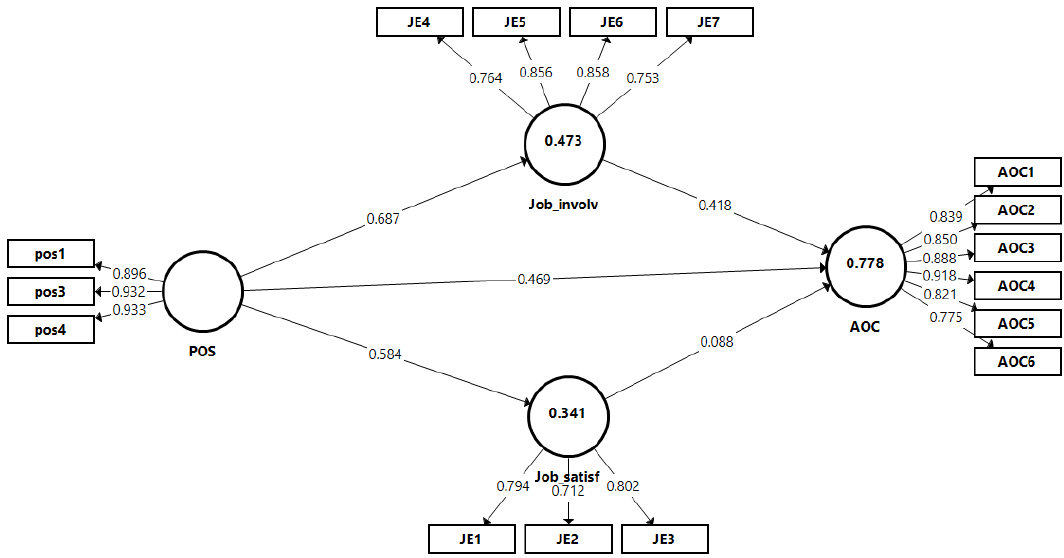
Figure 1. Structural model.